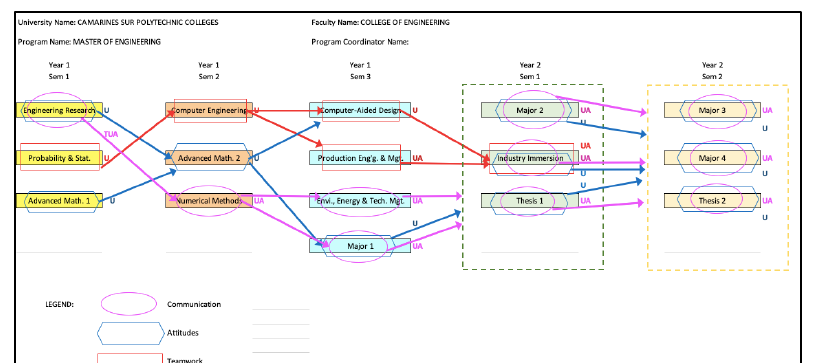
Fig. 3. Integrated Curriculum (Same for the Four